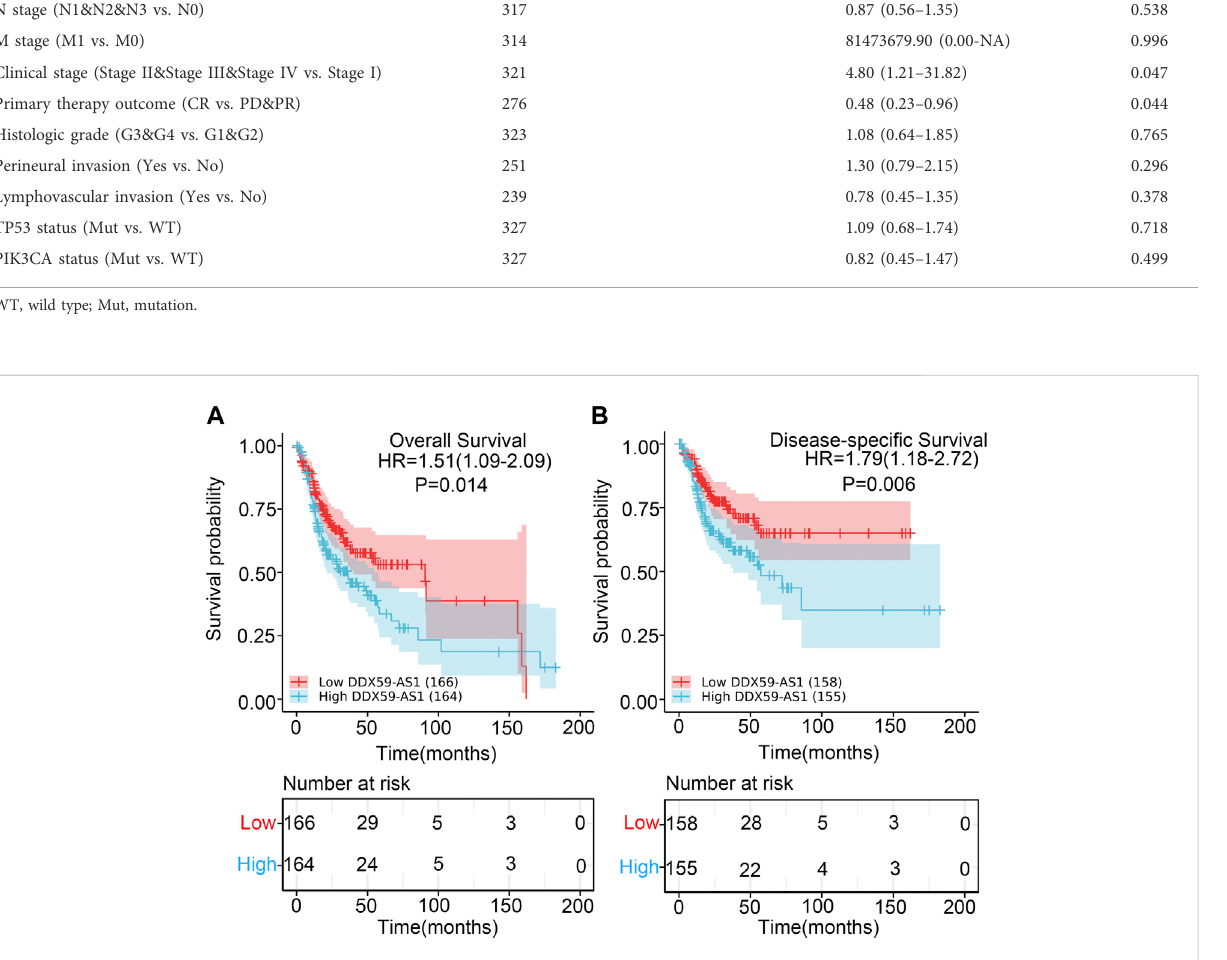
FIGURE 5 Kaplan-Meier survival curves comparing the high and low expression of DDX59-AS1 in OSCC patients. (A) Overall survival; (B) Disease-Speci fi c